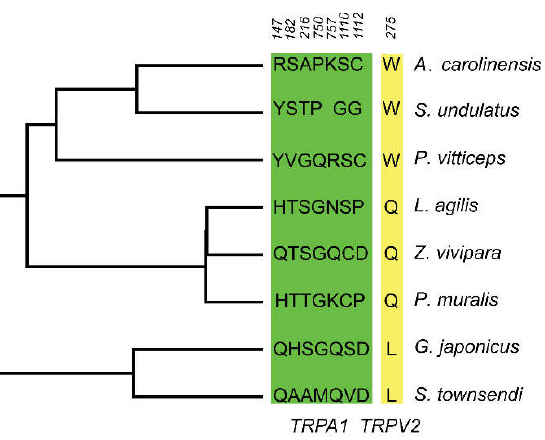
Figure 5. Amino acid changes in selected sites across the saurian phylogeny. Amino acid changes occurred in genes TRPA1 (green) and TRPV2 (yellow). The numbers represent the amino acid positions in the genes TRPA1 and TRPV2 .